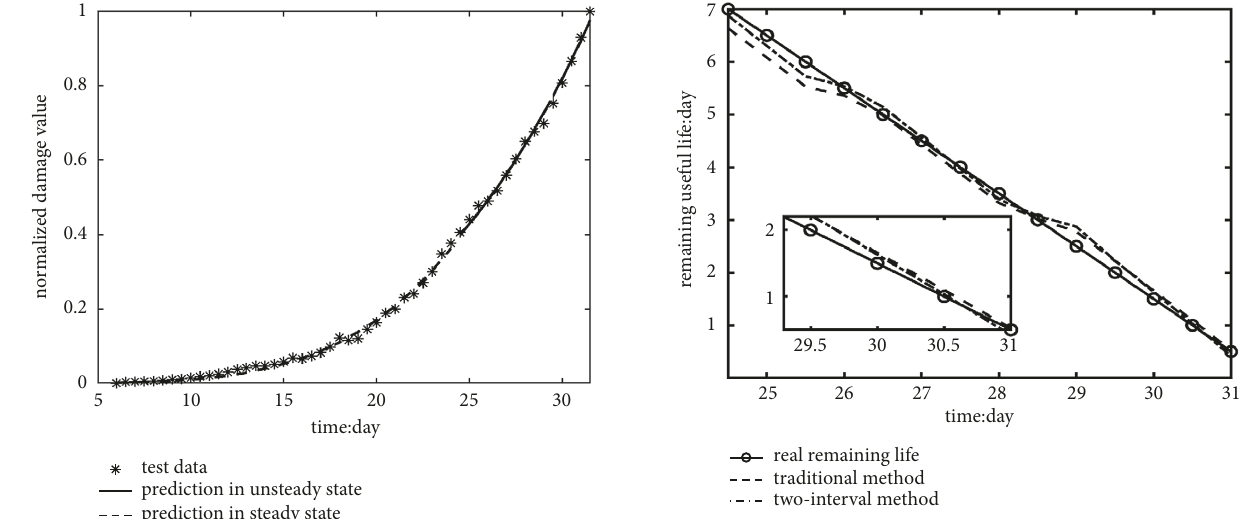
Figure 9: Predicted results of the proposed method.